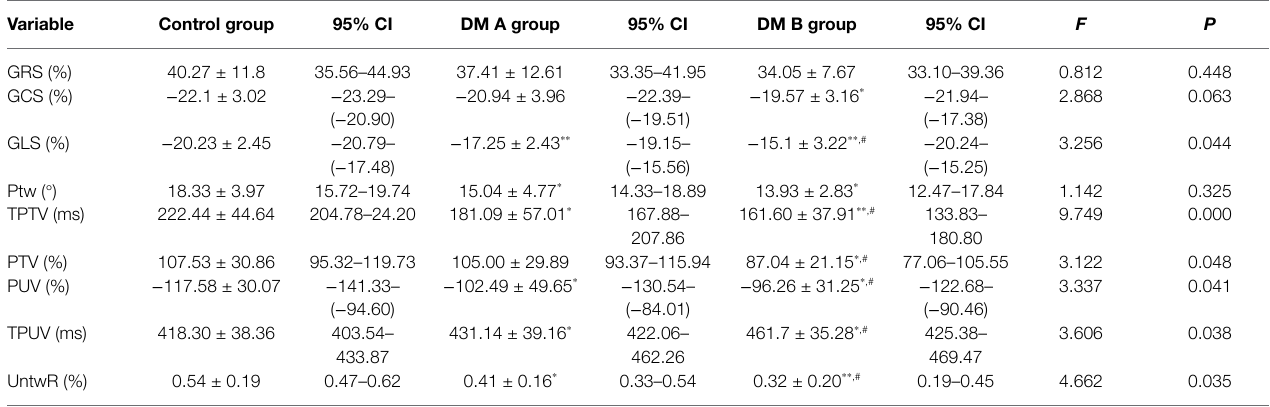
TABLE 3 | 2D strain and torsion parameters in the three groups. Variable